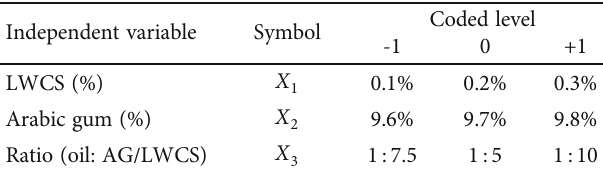
Table 1: Actual levels at coded factor levels of independent variables used in the